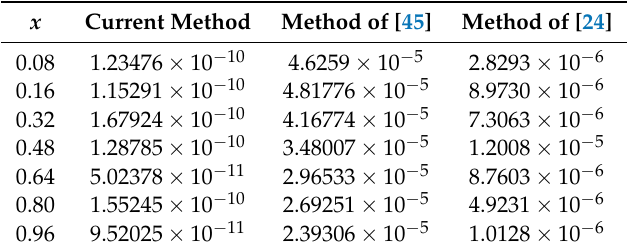
Table 1. Comparison of absolute error in y ( x ) for Example 1.